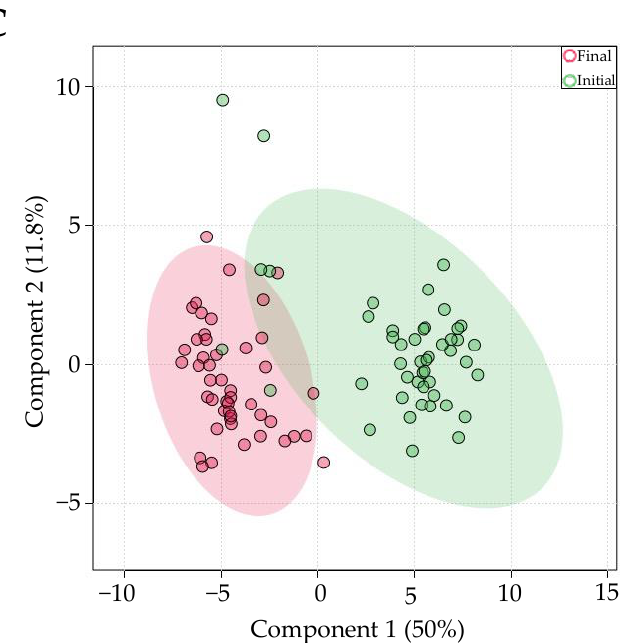
Figure 7. Intra-participant miRNA expression variability is greater in infants compared to young adults. PLS-DA revealed 3 distinct groups between time points when all samples are combined ( A ). When stratified by age, high miRNA expression overlap was shown in young adult samples ( B ), whereas distinct variation is shown between infant time points ( C ).